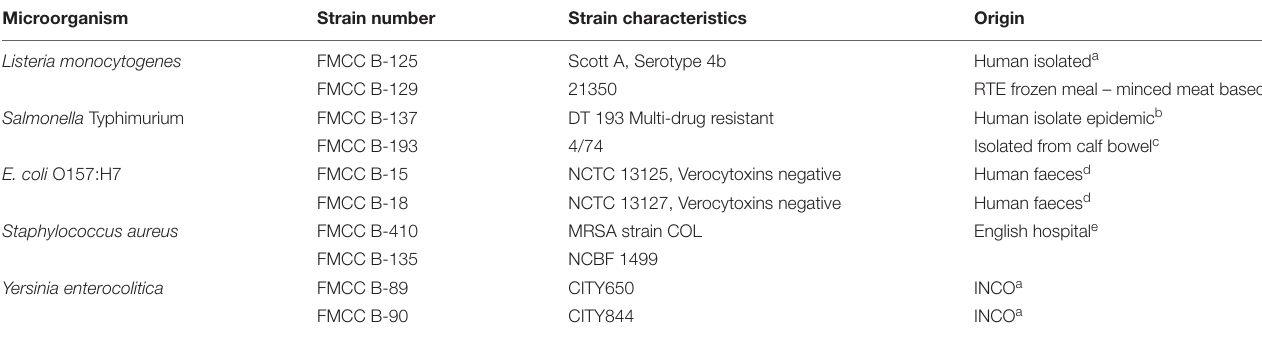
TABLE 1 | Bacterial species used in this study ∗